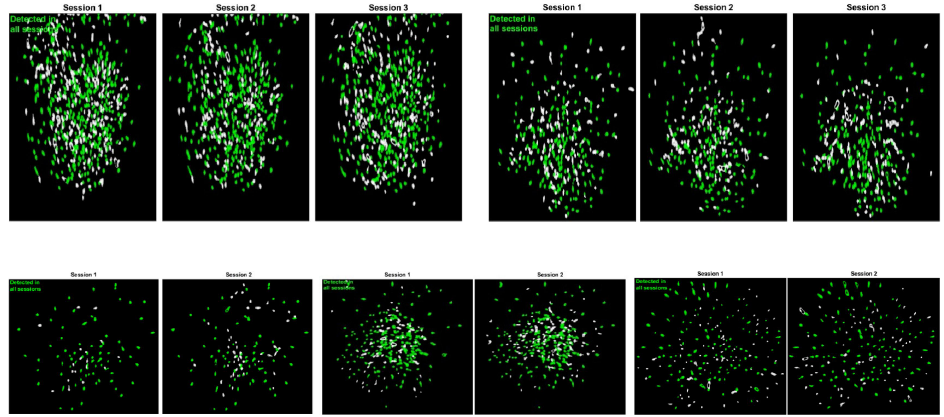
Figure A2. Samples of cell matching between sessions. Matched population is marked in